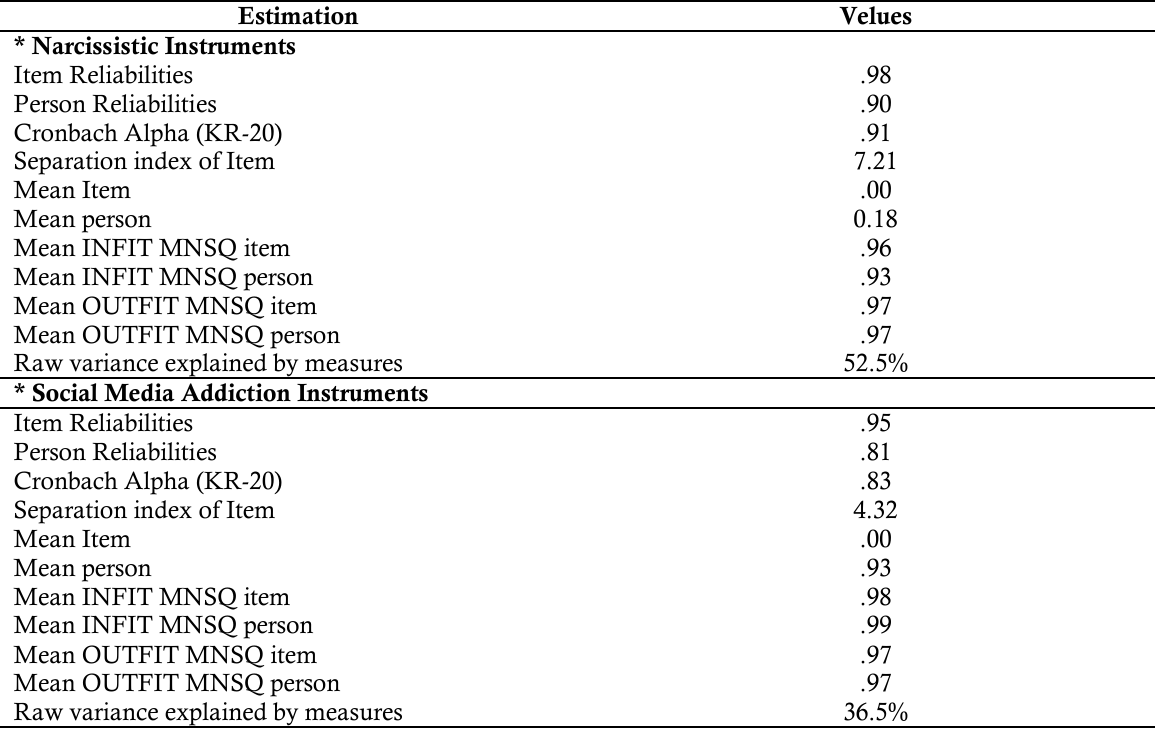
Table 2 . Narcissistic Instrument Quality (22 items) and Social Media Addiction (17